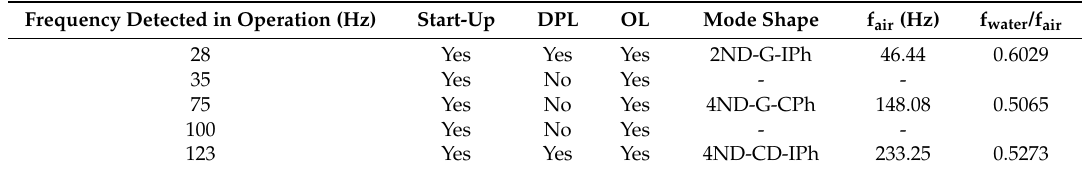
Table 3. Natural frequencies of the runner detected while in